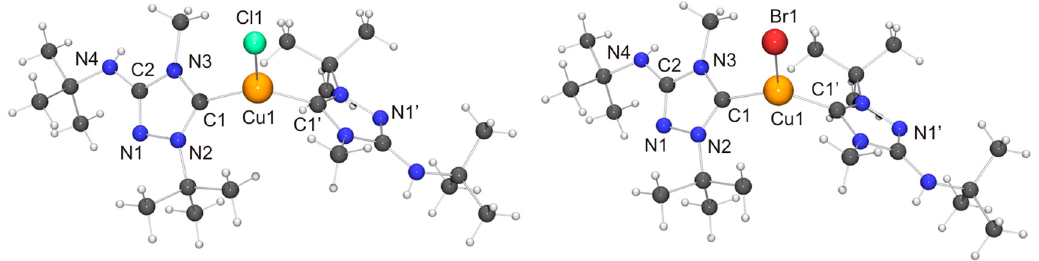
Figure 9. ( Left ) Molecular structure of [CuCl( 6 ′ ) 2 ] in the crystal. Selected bond lengths [Å] and angles [°]: C1 ‒ Cu1 1.940(6), C1 ‒ N2 1.348(7), C1 ‒ N3 1.366(7), C2 ‒ N1 1.308(8), C2 ‒ N3 1.372(7), C2 ‒ N4 1.357(8), N1 ‒ N2 1.405(7), Cu1 ‒ Cl1 2.336(2); N2 ‒ C1 ‒ N3 102.6(5), C1 ‒ Cu1 ‒ C1 129.5(3), C1 ‒ Cu1 ‒ Cl1 115.25(16); ( Right ) Molecular structure of [CuBr( 6 ′ ) 2 ] in the crystal. Selected bond lengths [Å] and angles [°]:C1 ‒ Cu1